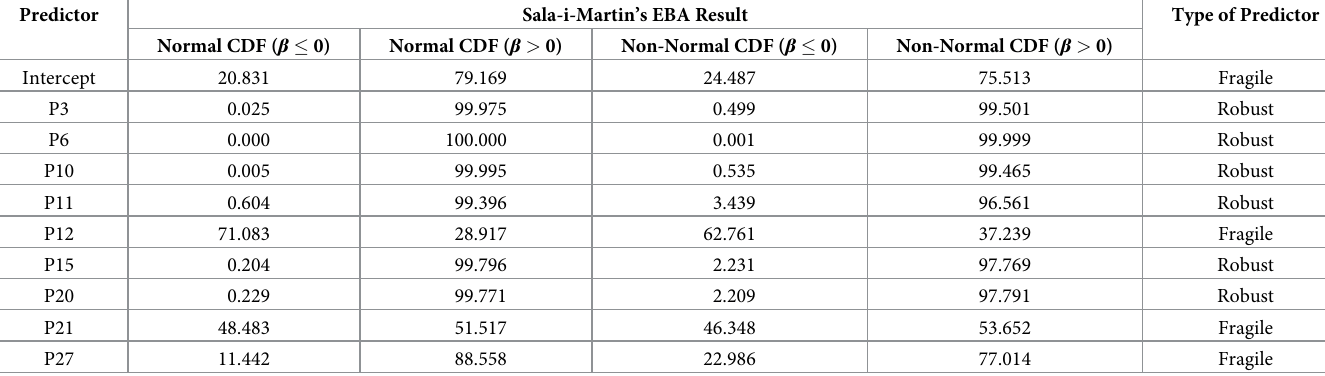
Table 12. Results of EBA analysis for schedule performance